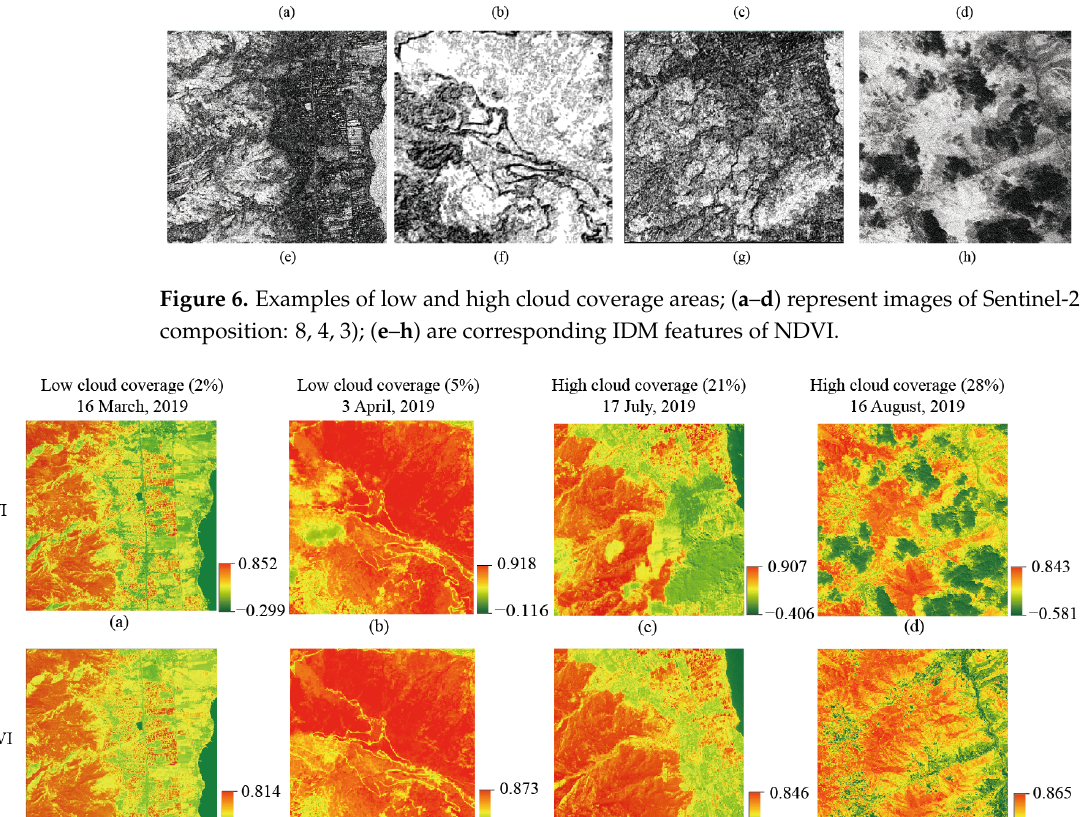
Figure 6. Examples of low and high cloud coverage areas; ( a – d ) represent images of Sentinel-2 (band composition: 8, 4, 3); ( e – h ) are corresponding IDM features of NDVI.